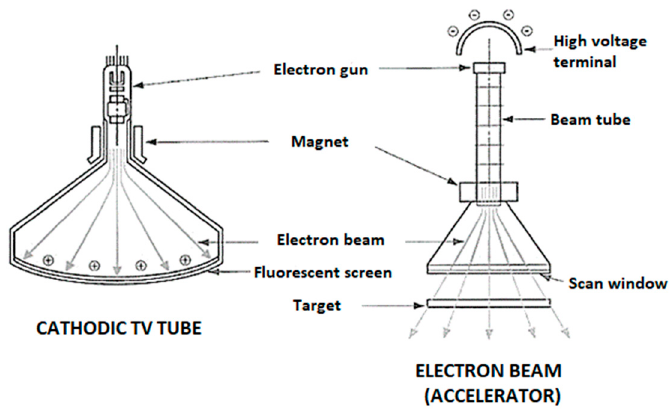
Figure 4. Cathodic tube television set ( left ) vs. EB ( right ).